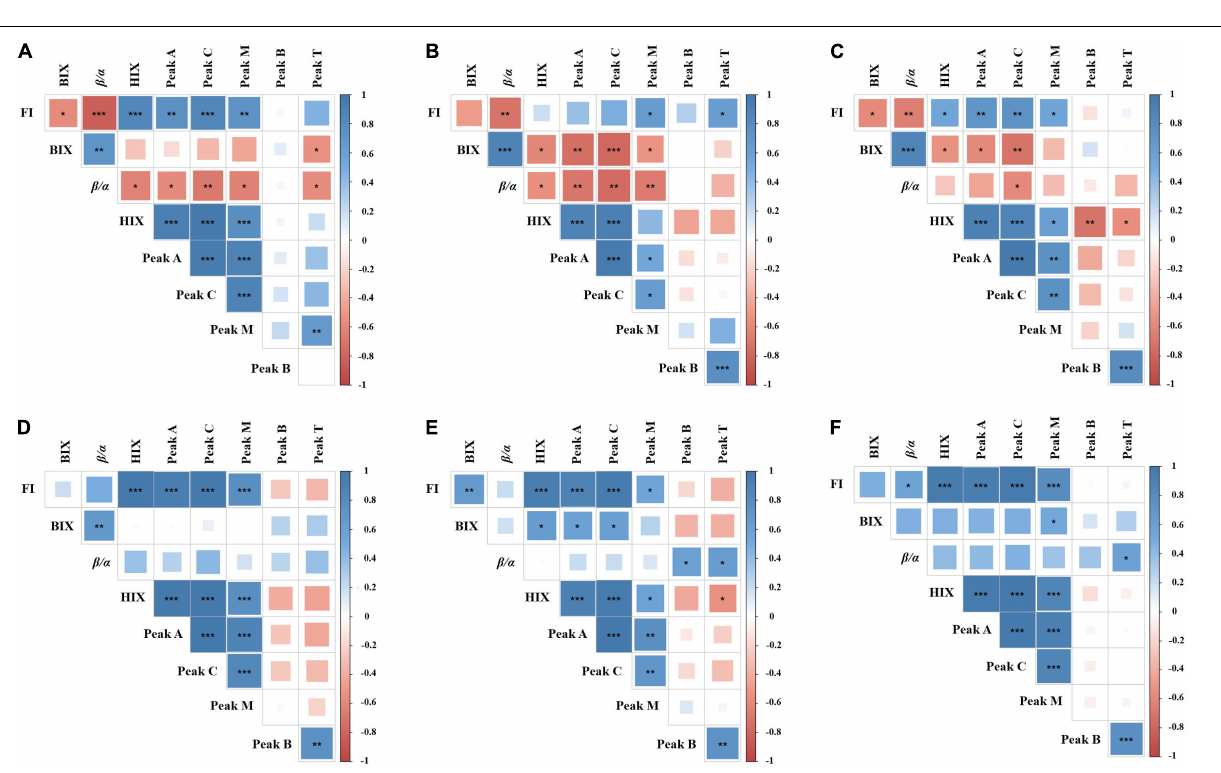
FIGURE 4 | Correlation matrix among different fluorescence peaks and indices parameters. (A–C) Represent Roseobacter sp. + DOM, Marinobacter sp. + DOM, and Bacillus sp. + DOM, respectively. (D–F) Represent Roseobacter sp. + LOM, Marinobacter sp. + LOM, and Bacillus sp. + LOM, respectively. The color and size of the square circle indicate the Pearson’s correlation coefficient. *, **, and *** indicate significance levels at p < 0.05, p < 0.01, and p < 0.001, respectively. The blue color indicates a positive correlation and the red color indicates a negative